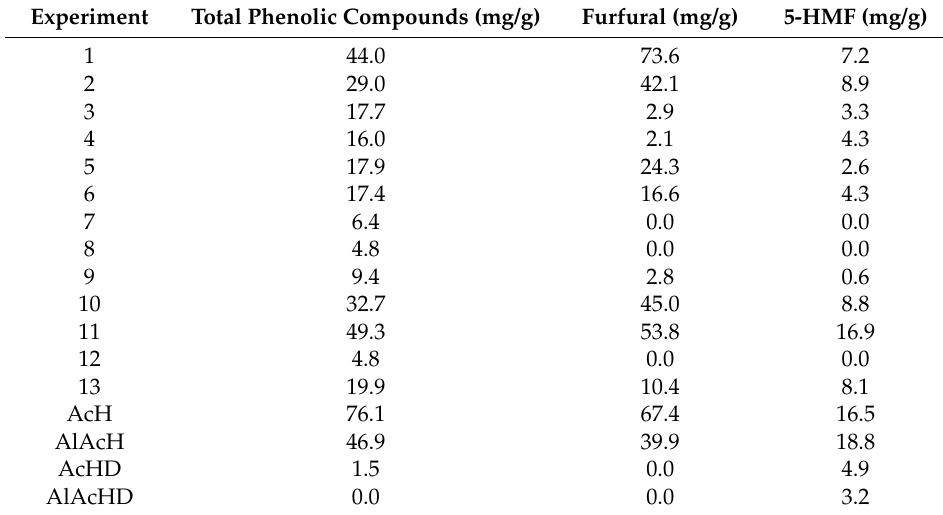
Table 7. Determined inhibitors of